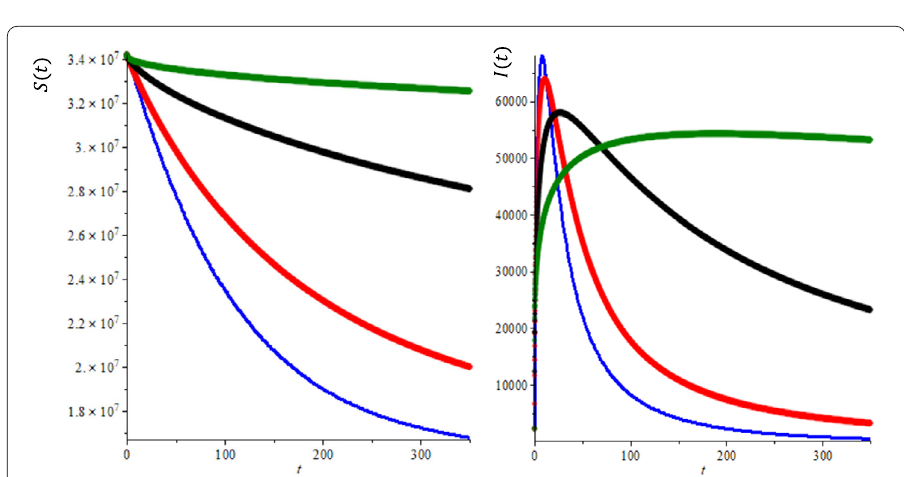
Figure 4 Comparison of between the results of integer order derivatives (blue line, α = 1), fractional order of derivatives ( α = 0.9 (red line), α = 0.7 (black line) and α = 0.5 (green line) for b = 100, k = 5000 and R 0 =